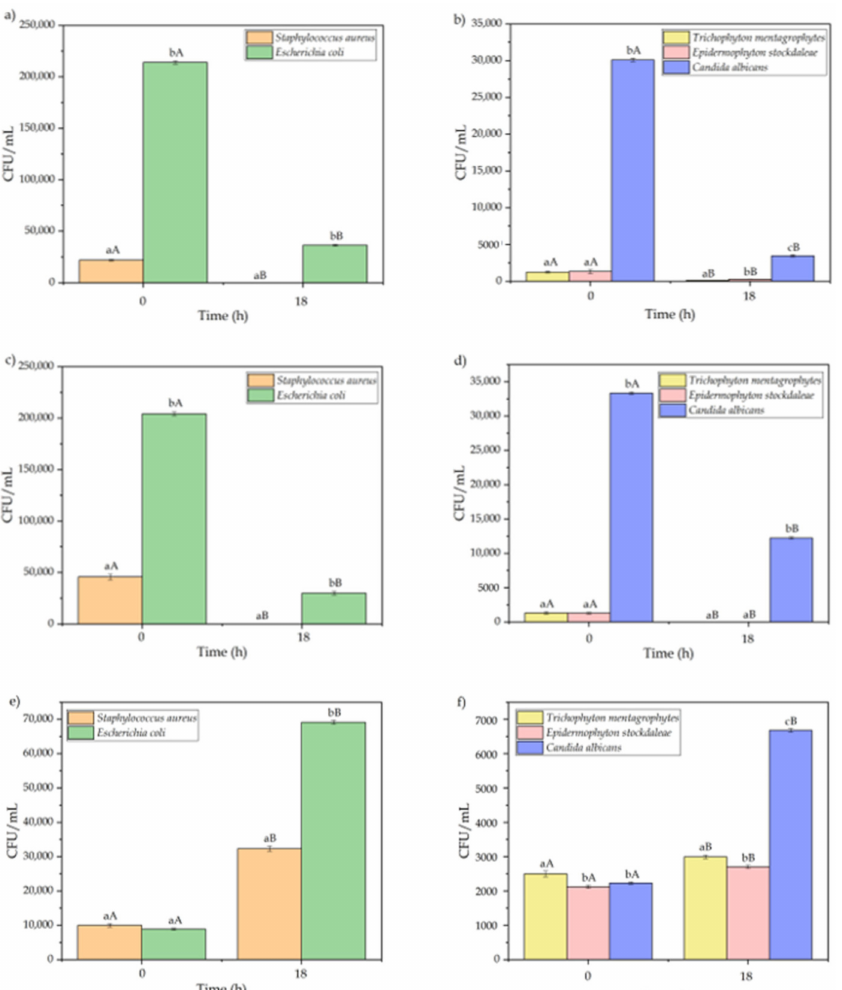
Figure 3. Antibacterial and antifungal activities in terms of colony-forming units (CFU/mL) of chitin fibers ( a , b ), soy protein (SP) fibers ( c , d ), and coir fibers ( e , f ). a–c Different letters in the same period for different samples indicate a significant difference ( p < 0.05). A,B Different letter of the same sample in different periods indicate a significant difference ( p <